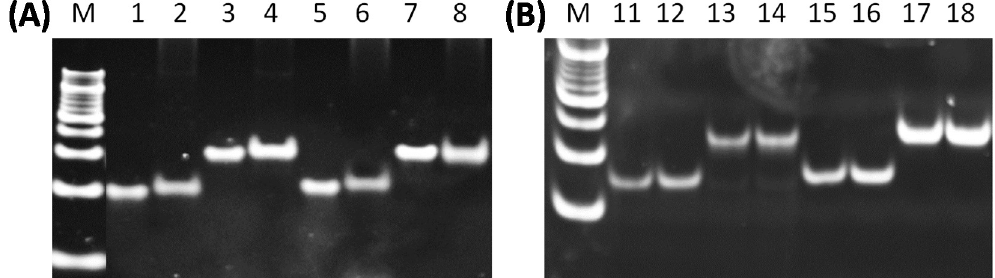
Figure 3. 25, 30, and 35bp DNA:RNA each alone packaged efficiently. ( A ) 1, 2: input and